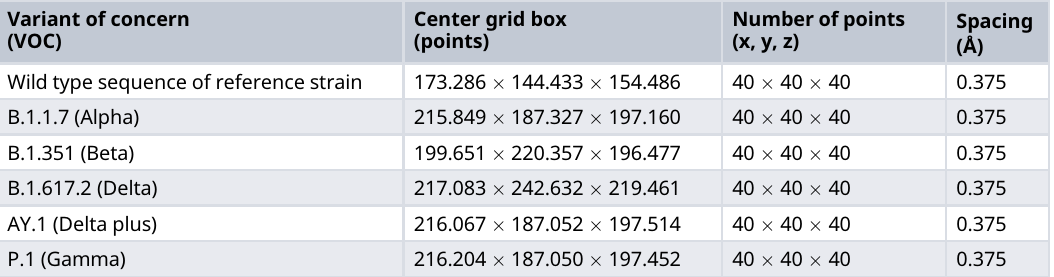
Table 2. Grid box parameters selected for surface glycoprotein of different variants of concern (VOCs). Variant of concern